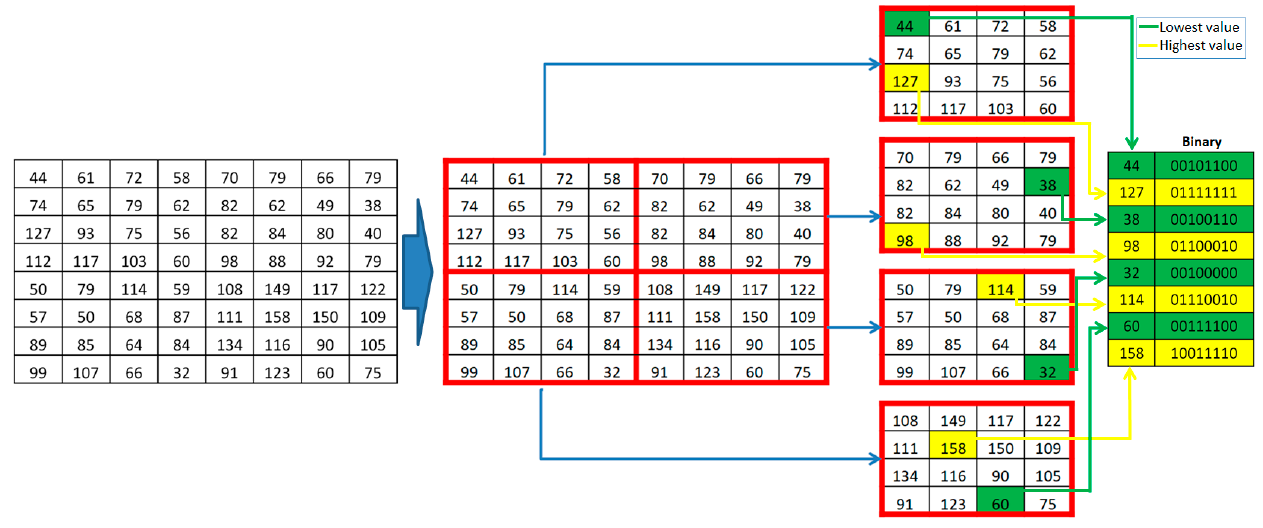
Figure 2. Example of the preparation of a cover image .